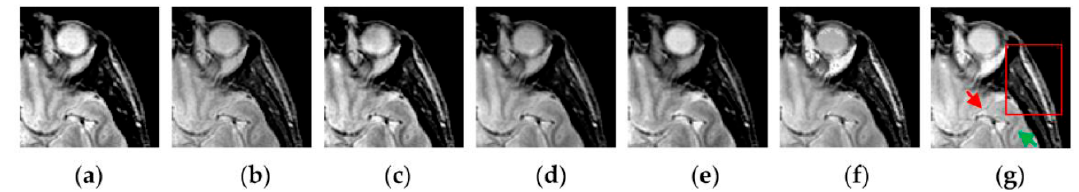
Sensors 2016 , 16 , 1503